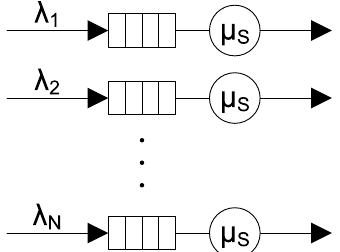
Figure 5. Queueing model of virtualized hardware with N queueing stations. Each queueing station (representing a data stream) consists of a FIFO queue and associated server representing oual copy of the hardware